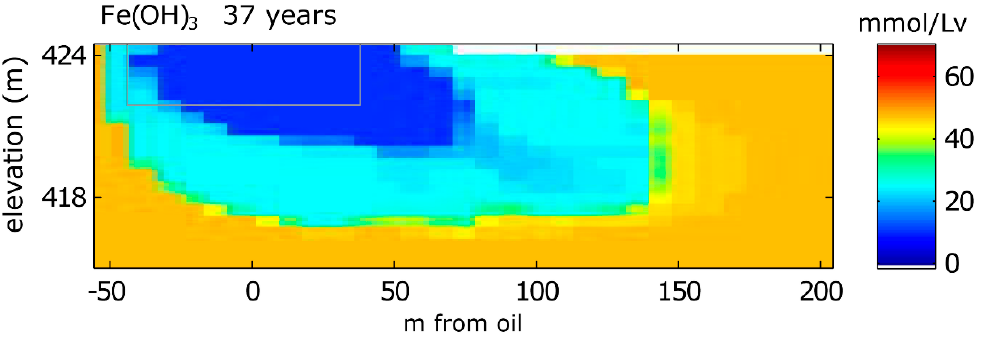
Figure 4. Model simulation results for solid phase concentrations of Fe(OH) 3 in 2016 (37 years after the oil spill). The gray box is the reference for the extent of the oil body. The top boundary is the water table.